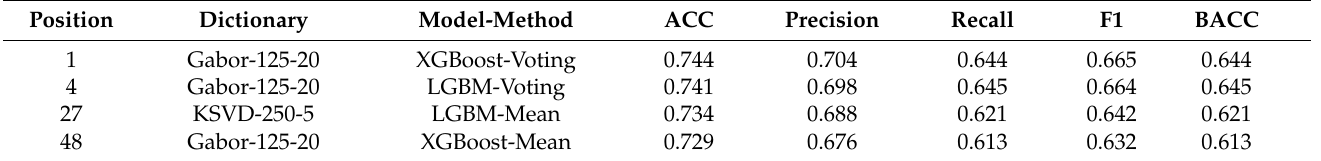
Table 4. Summary of average metrics scores for each data model, class size = 5.